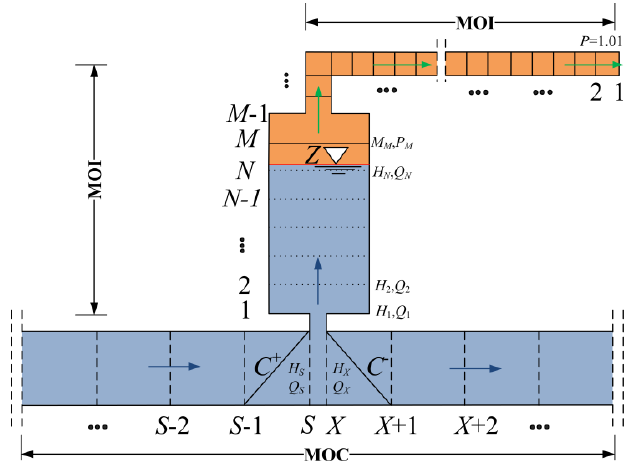
Figure 22. Surge tank with air